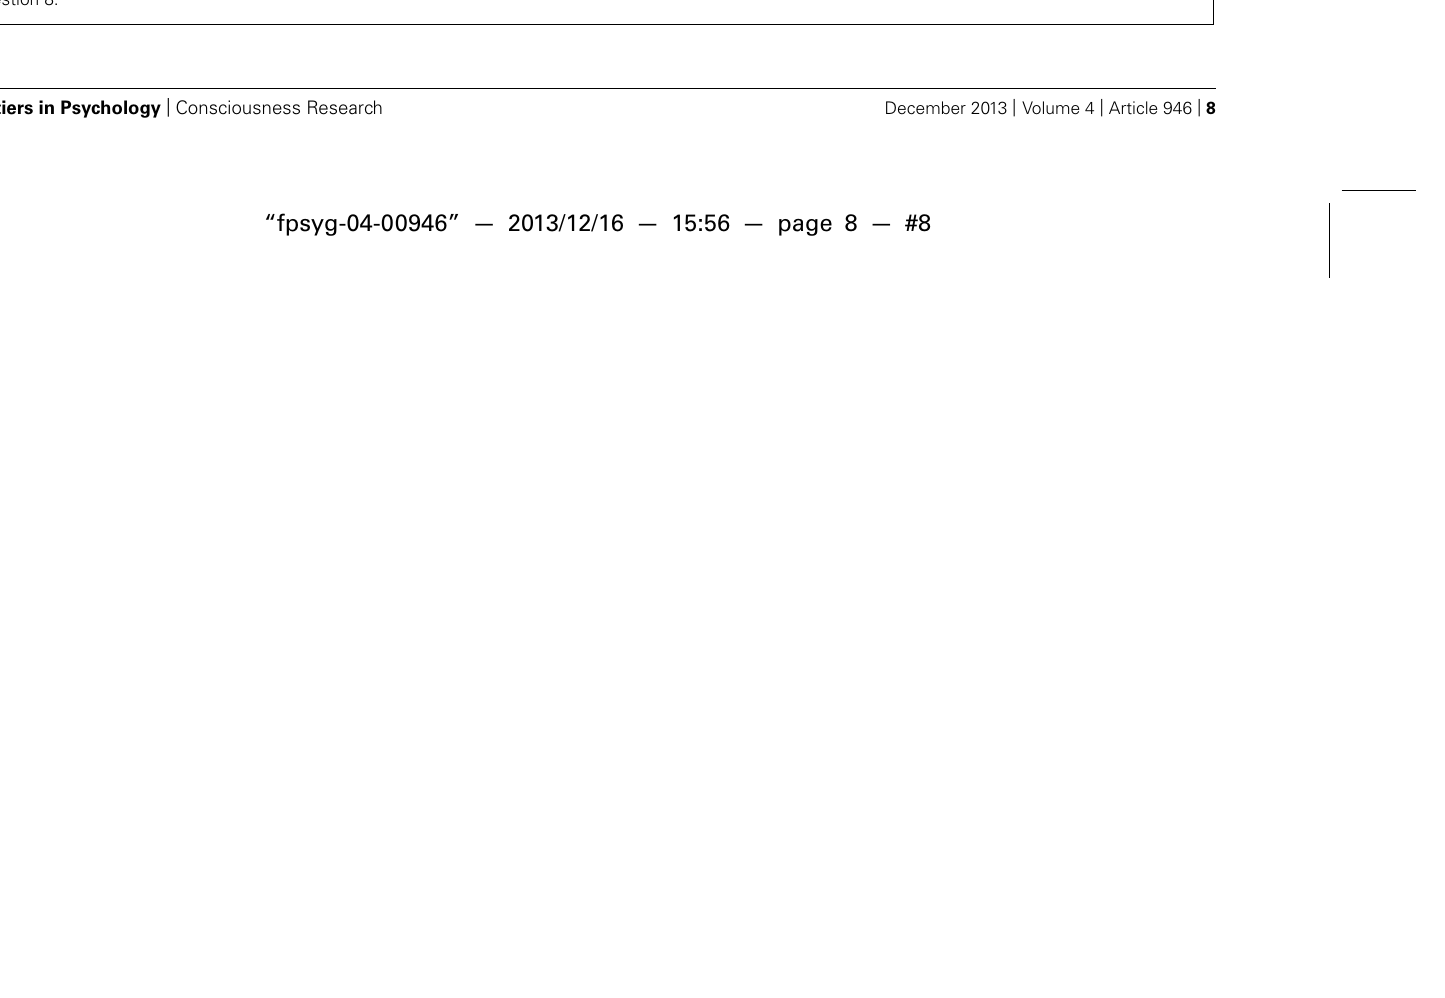
FIGURE 6 | Question 8 results for Study 1 and Study 2. This figure shows the frequency counts for the response categories left, both, and right for question